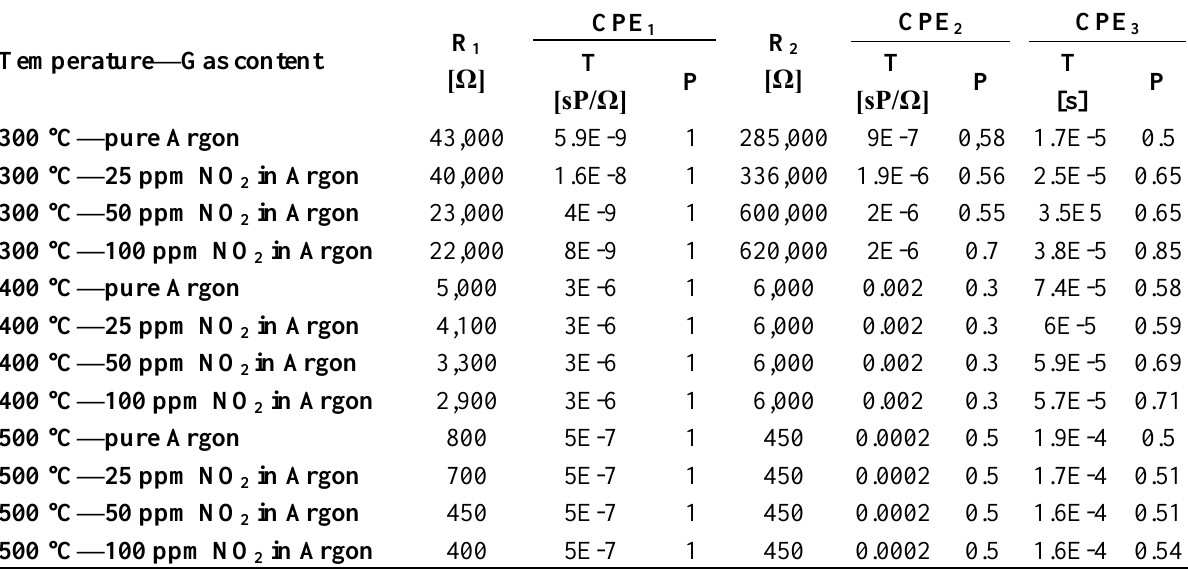
Table 2. Fitting parameters of the Cr doped TiO